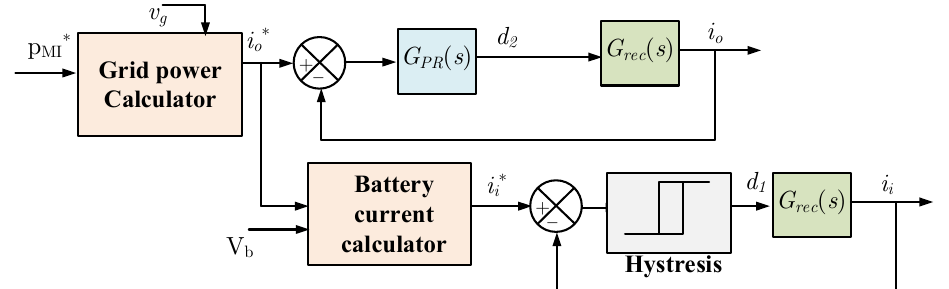
Figure 12. MCI controller during AC/DC conversion to charge the battery.